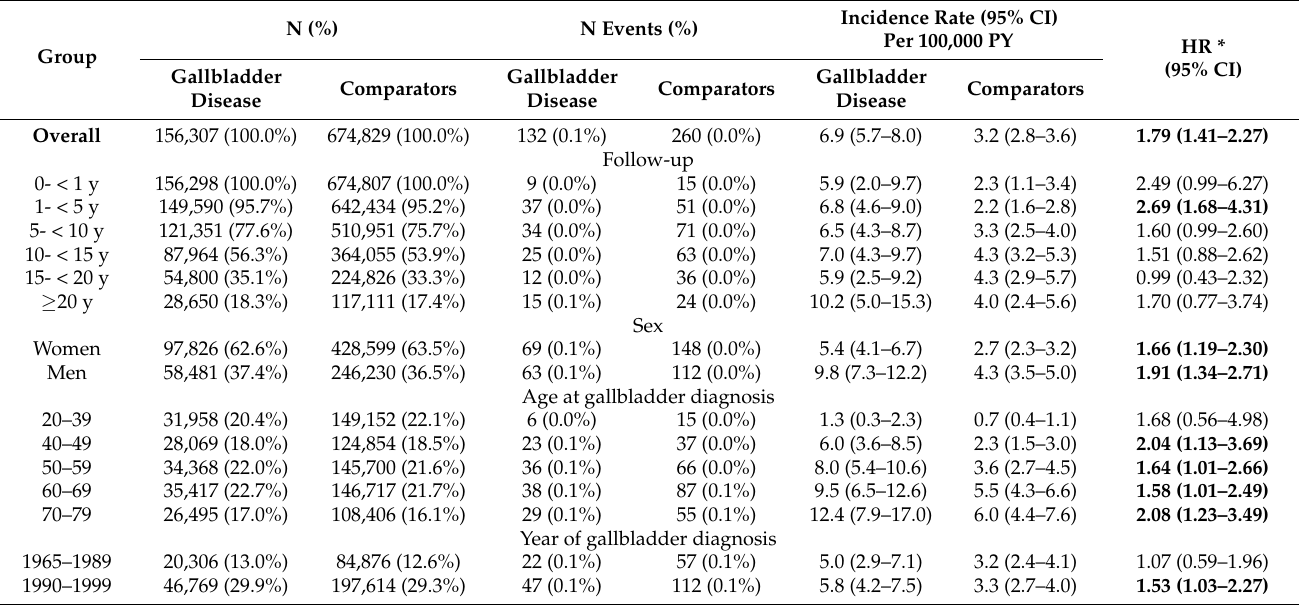
Table 3. Stratified risk of small bowel adenomas in individuals with gallbladder disease and matched general population